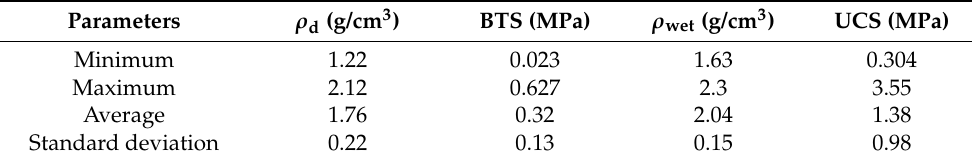
Table 3. The minimum, maximum, average, and standard deviation of the dataset.